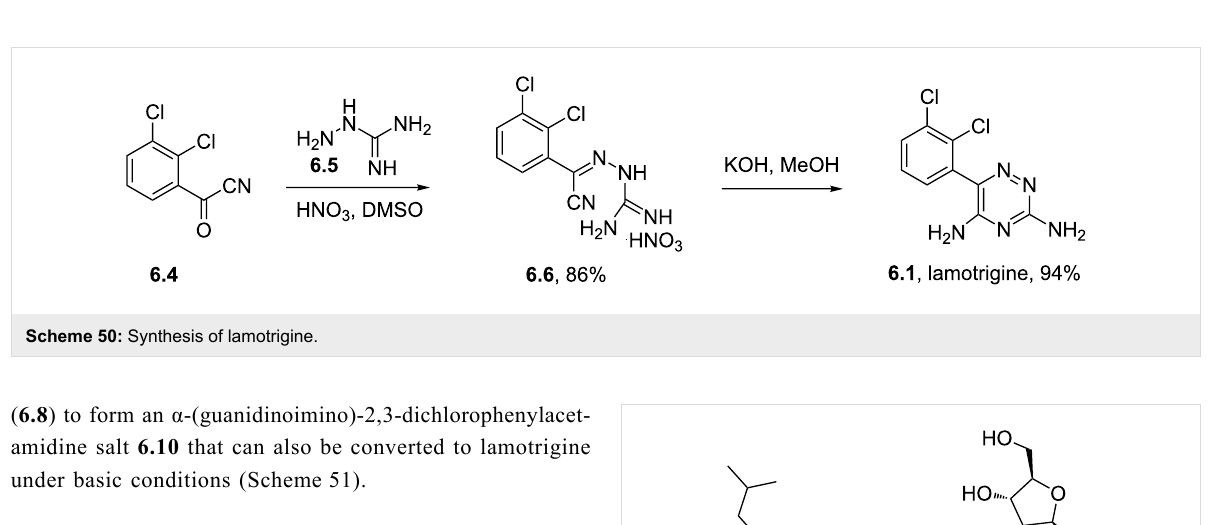
Figure 16: Structures of lamotrigine, ceftriaxone and azapropazone.